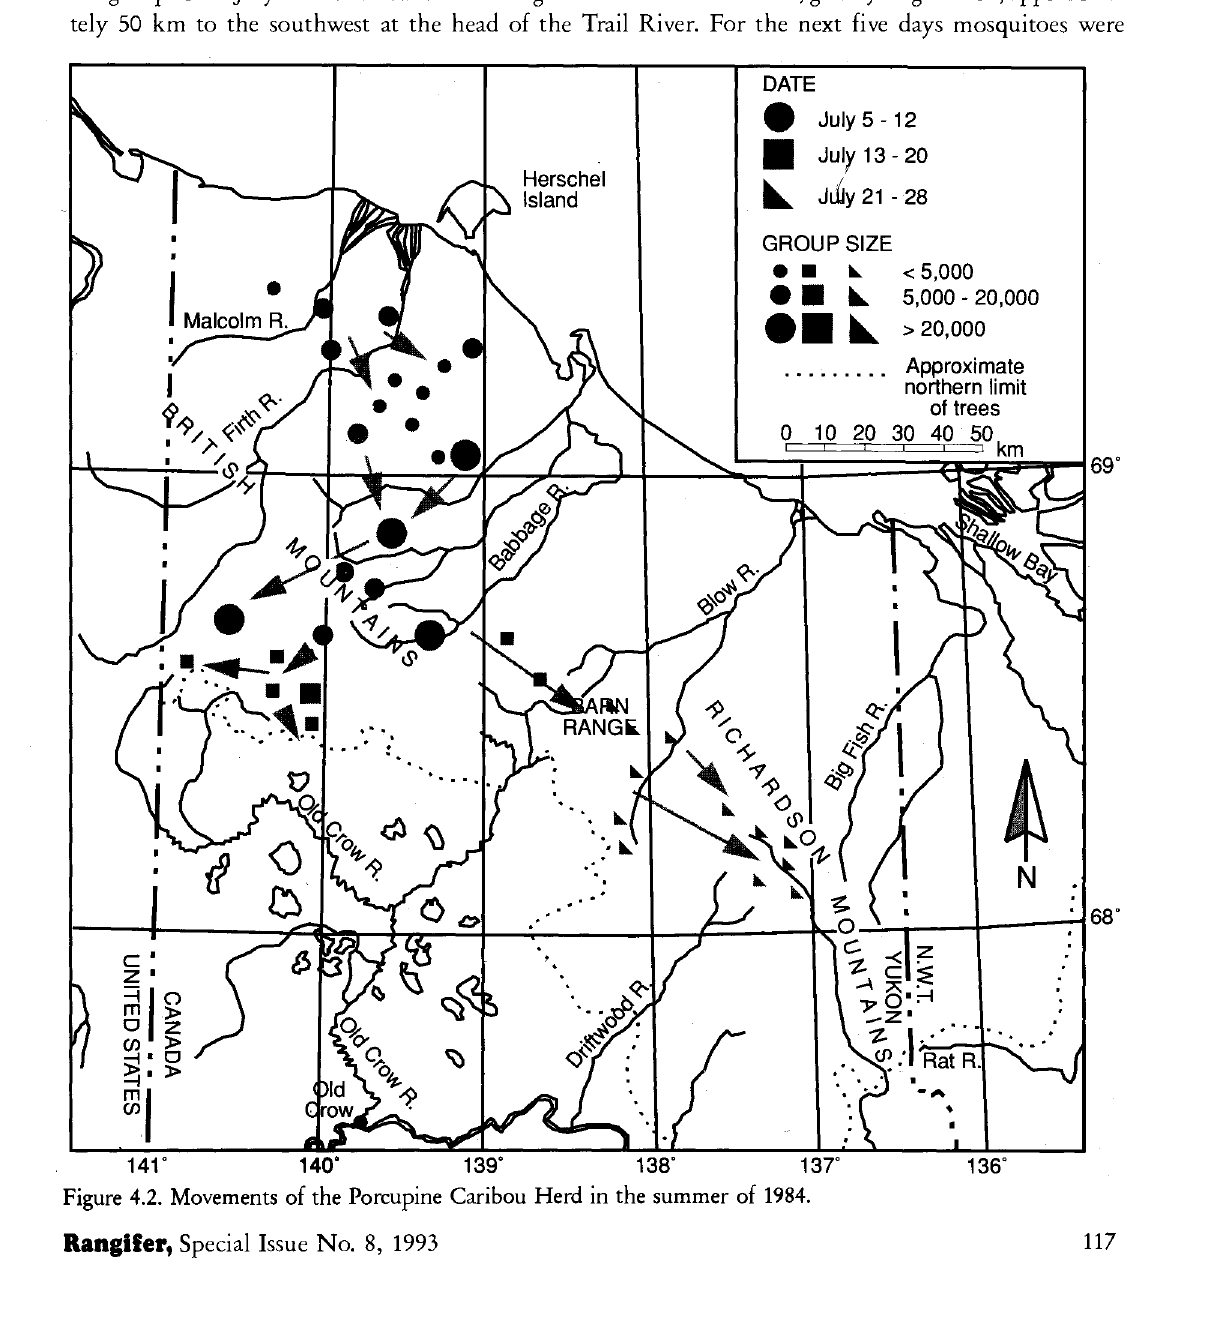
Figure 4.2. Movements of the Porcupine Caribou Herd in the summer of